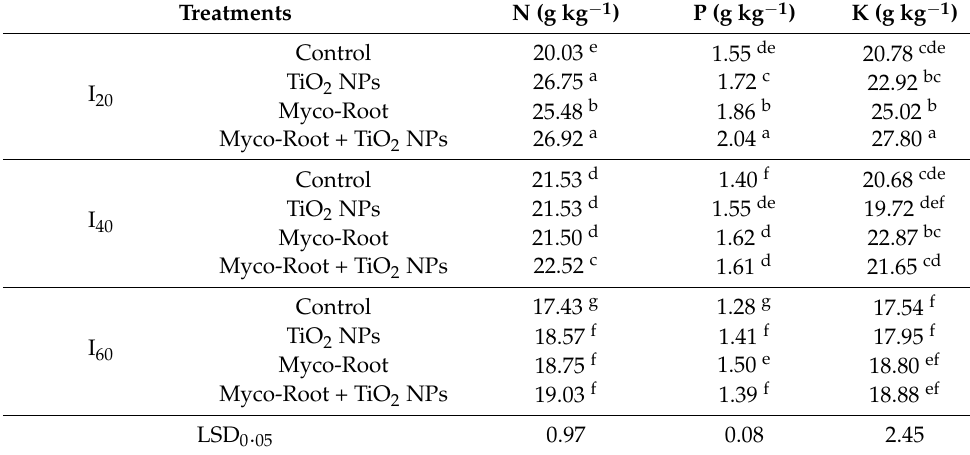
Table 3. The concentration of nitrogen (N), phosphorus (P), and potassium (K) of peppermint in different irrigation regimes and fertilizer